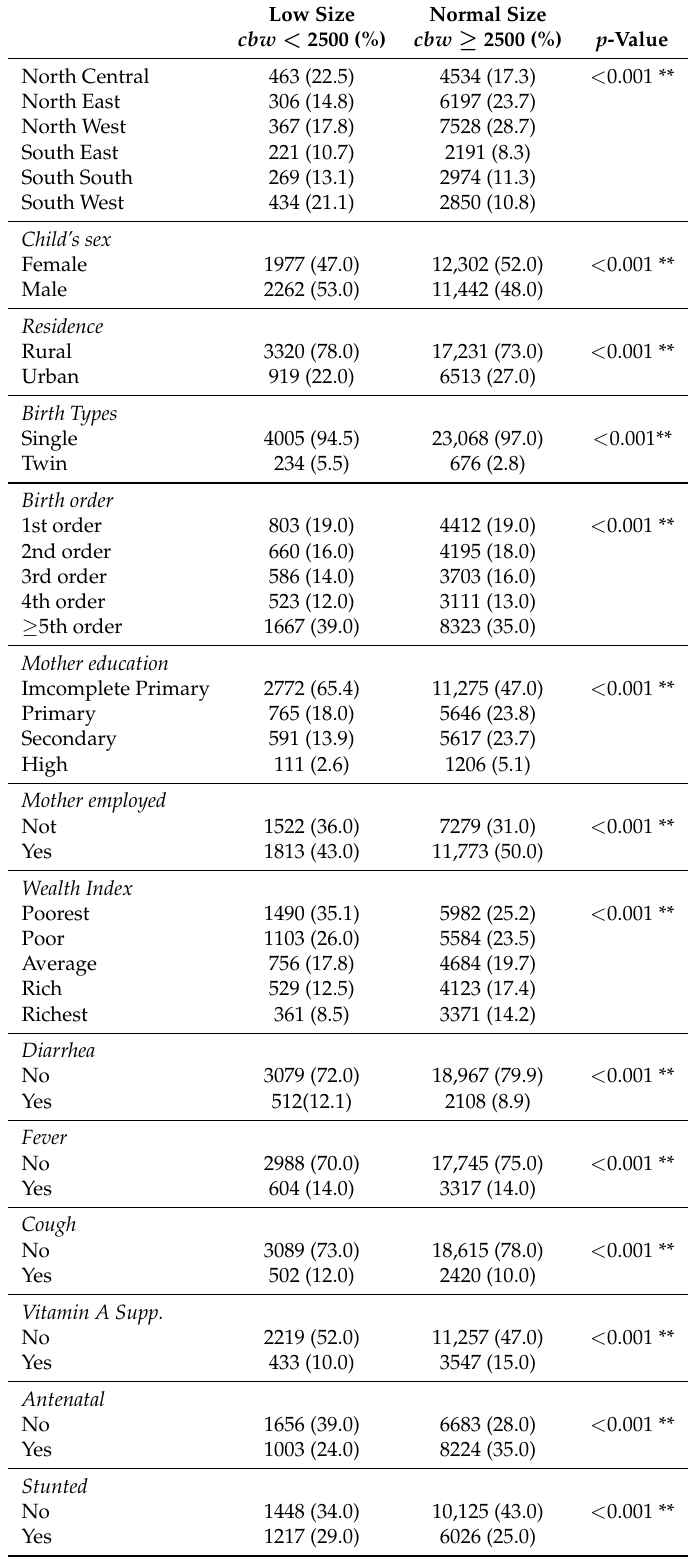
Table 2. Frequency distribution of some categorical covariates by Two-way classification and Bivariate